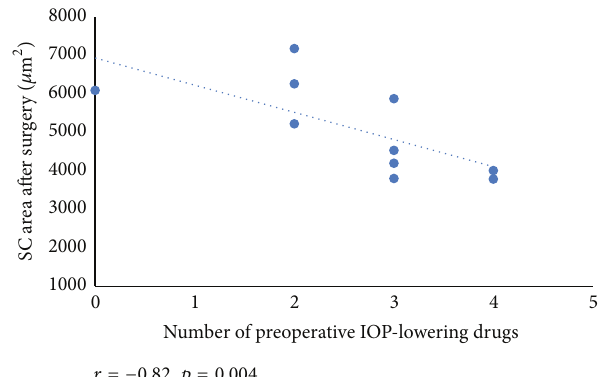
Figure 5: Scattergram showing the relationship between the SC area after surgery and glaucoma medication before